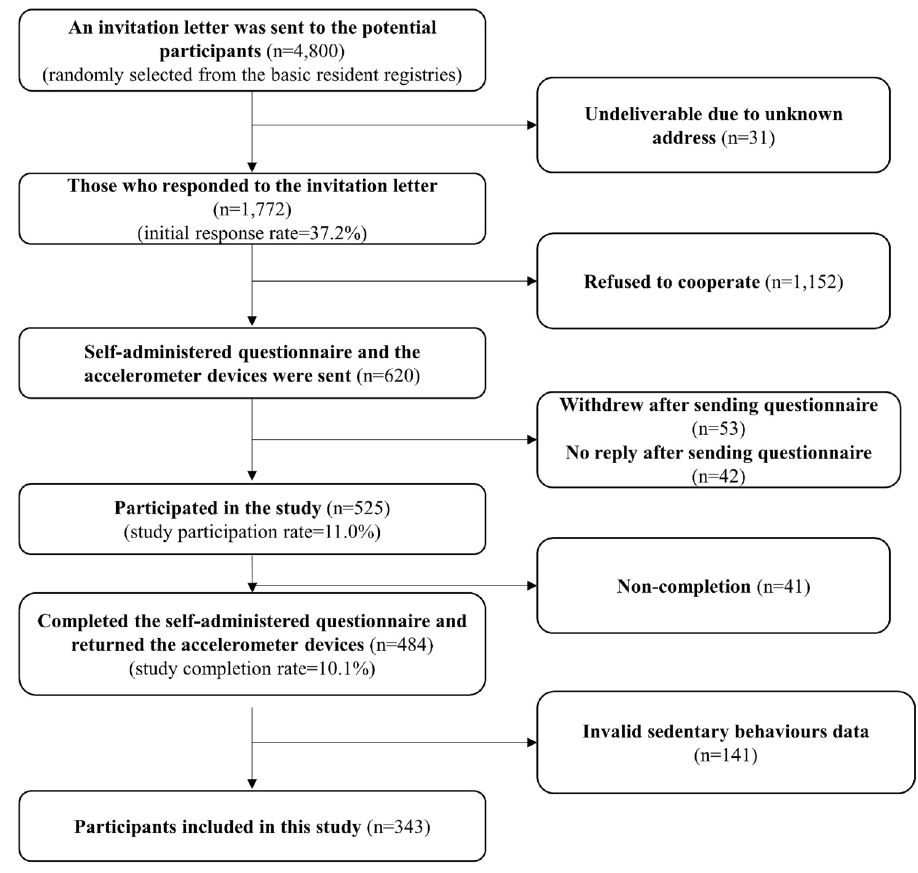
Figure 2. Flow diagram of participants in the